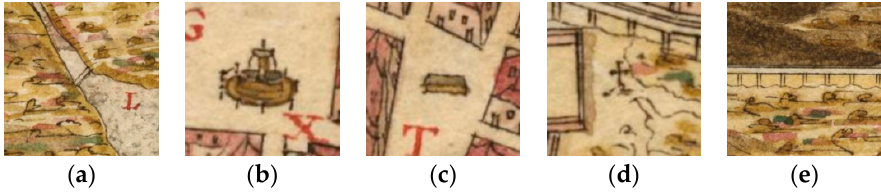
Figure 5. Other map elements in Torriani’s map. ( a ) bridge, ( b ) fountain, ( c ) water trough, ( d ) religious cross, ( e ) water conduit. cross, ( e ) water